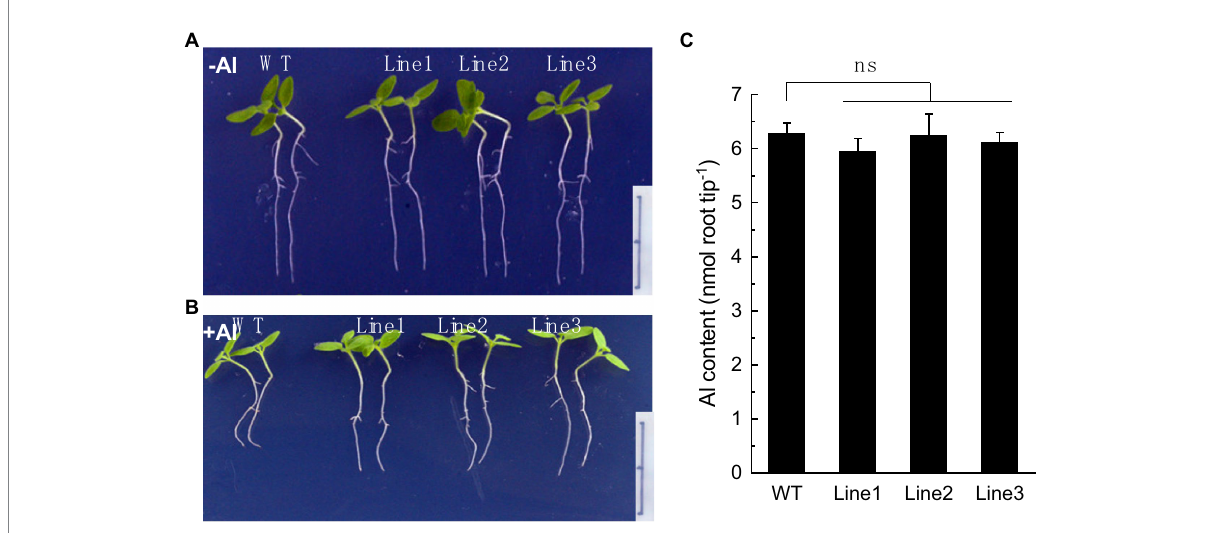
FIGURE 6 RyALS3;1 confers Al tolerance in transgenic tobacco lines. (A) Growth of both WT plants and three independent transgenic plants in the absence of Al. (B) Growth of both WT plants and three independent transgenic plants in the presence of 5 μ M Al. Note that the transgenic lines have much longer root elongation than WT plants. Bar = 1 cm. (C) Al content in root apex of both WT and transgenic lines. Data are means ± SD ( n = 3). ns: not statistically